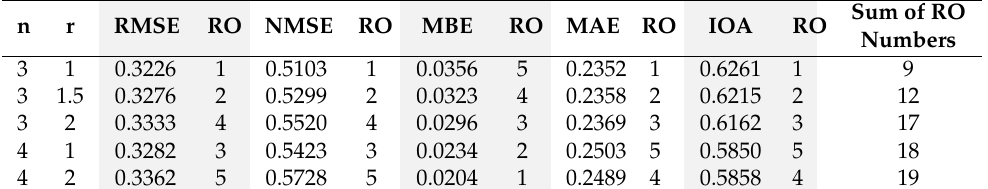
Table 6. The calculated statistical metrics for the evaluated IDW interpolators for N-NH 4 , the ranking order of each interpolator and the sum of the ranking order